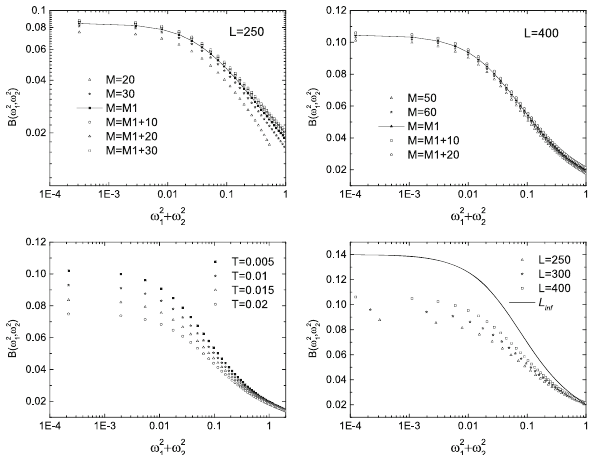
Fig. 1 The behaviors of boson polarization with different summation upper bounds (Left) and range of volume(with M = 300) at T = 0 . 01 , m = 0 . 01 (Right), and the solid line L inf illustrates the behavior of Eq. (13)